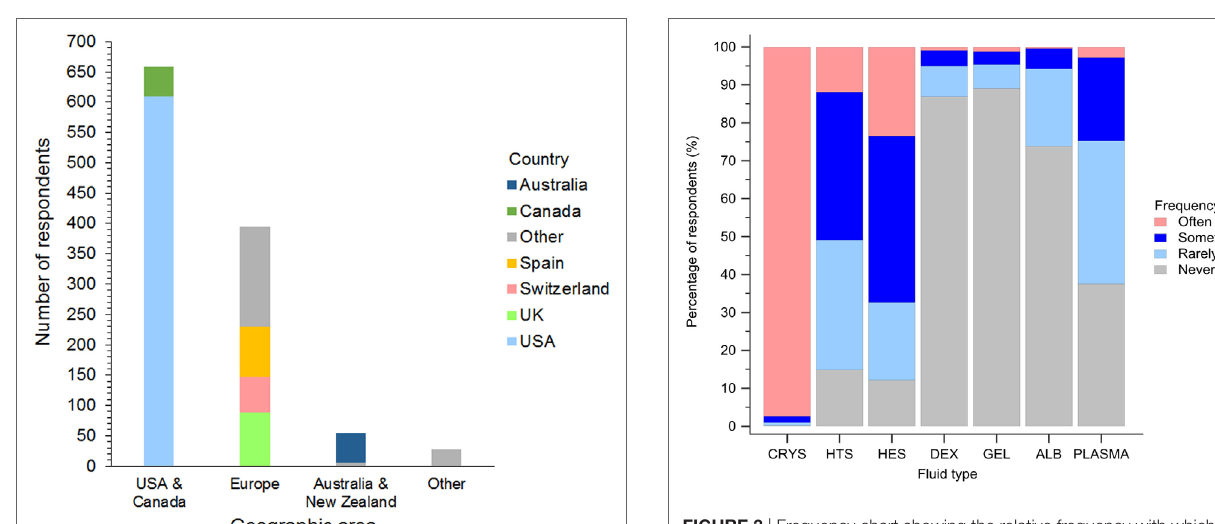
FigUre 3 | Frequency chart showing the relative frequency with which the 1,134 survey respondents use intravenous solutions for fluid